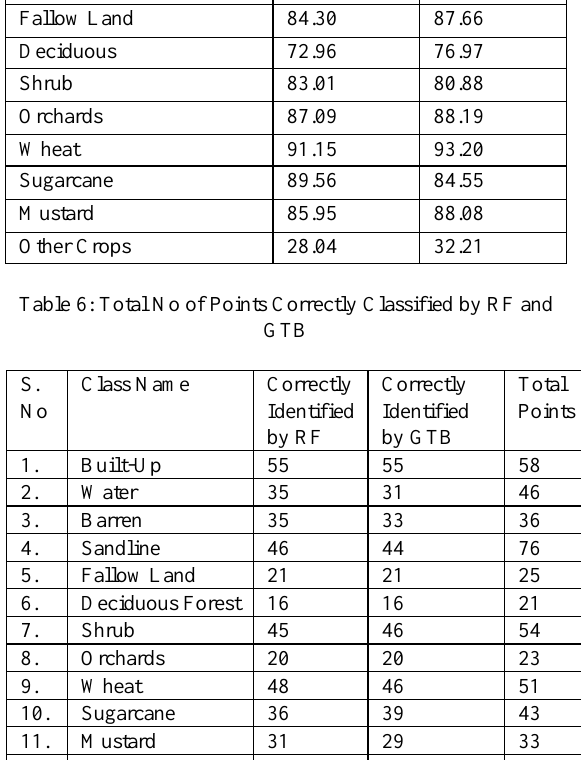
Figure 4. Classified Map generated using Random Forest (RF)